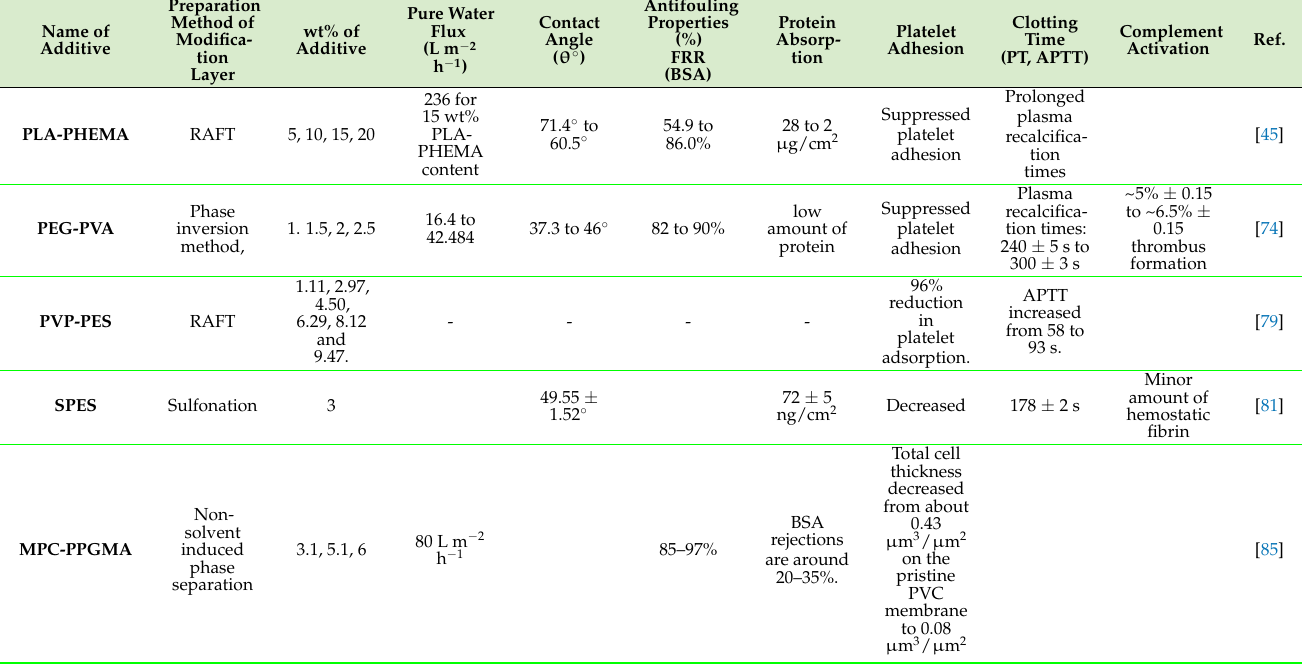
Table 1. Comparison of combining different additive blocks on membrane